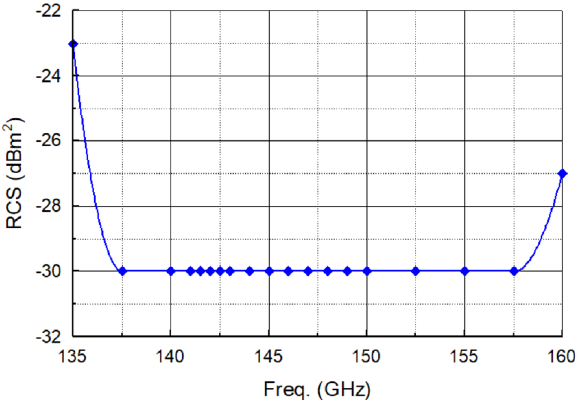
Figure 7. Measured radar cross section (RCS) of the proposed OCA tag.